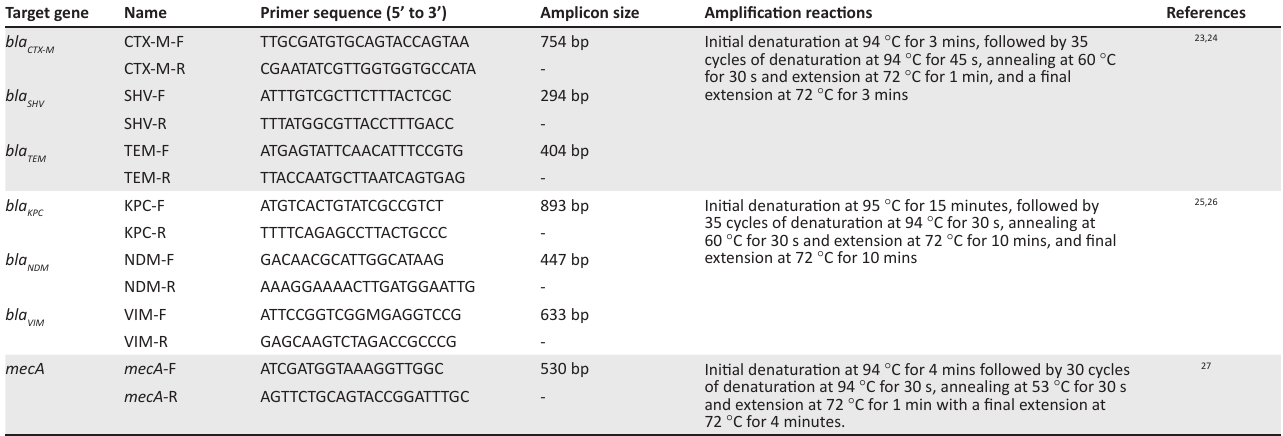
TABLE 1: Oligonucleotides primers and amplification reactions for targeted resistance genes. Target gene